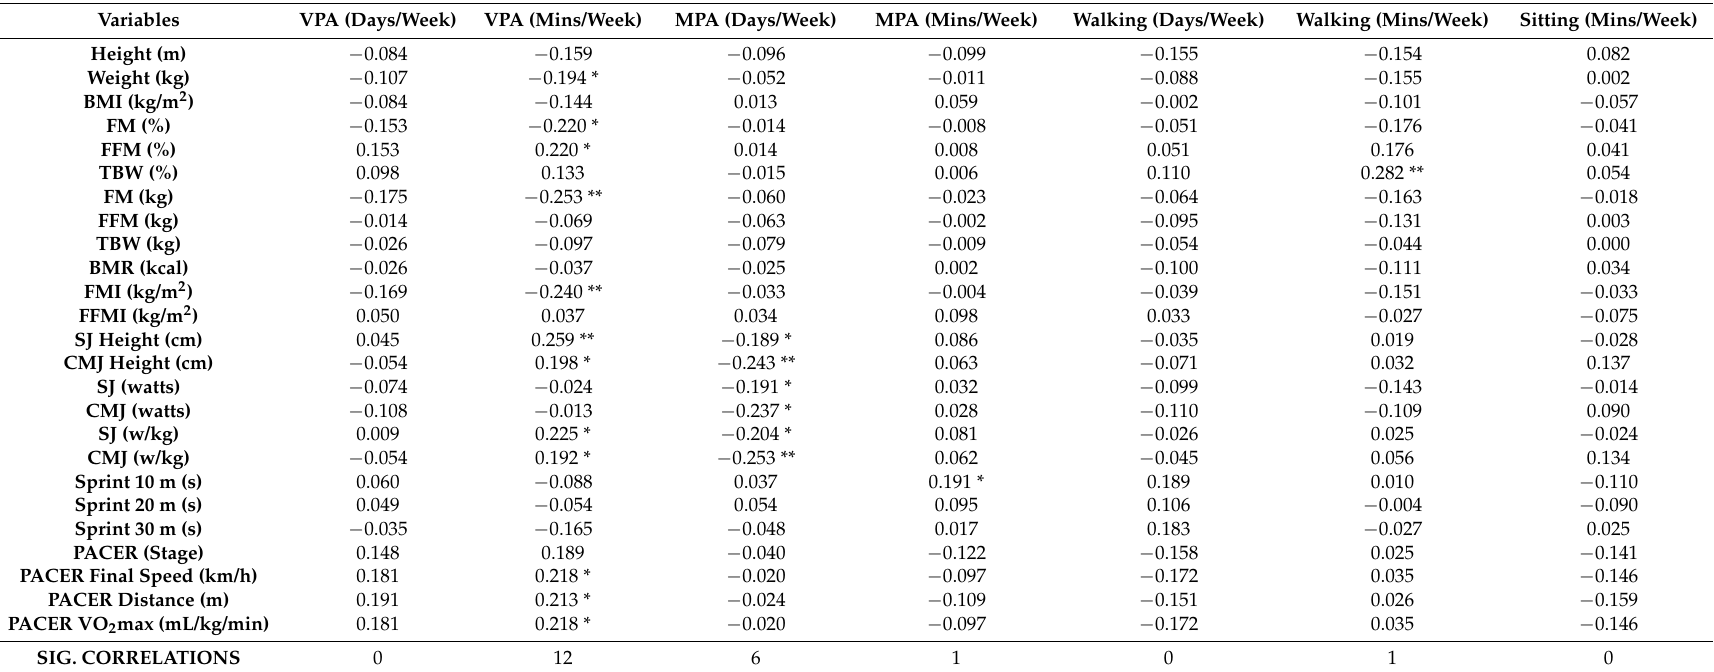
Table 5. Correlations physical activity—body composition and physical